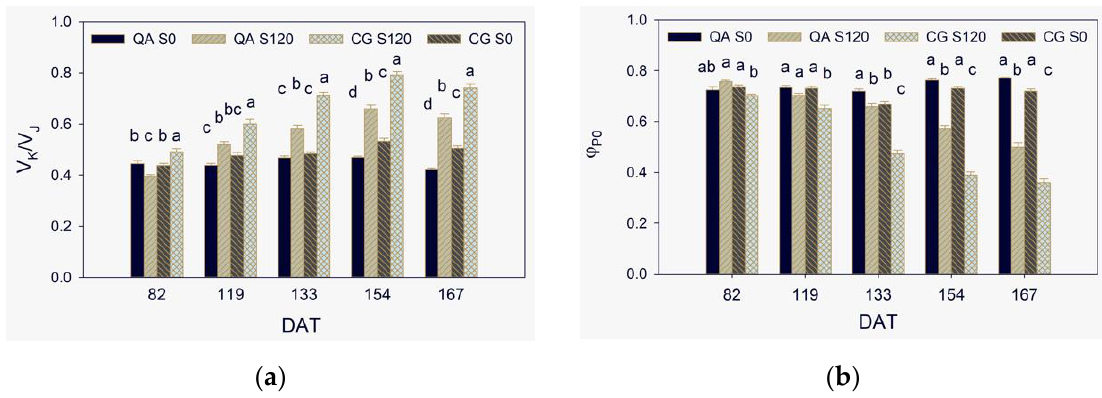
Figure 2. The ratio of V K to V J ( a ) and the maximum quantum yield of primary PSII photochemistry, ϕ Po ( b ) from DAT 82 to DAT 167. Values are the means of 24 replicates. The vertical line on each bar represents the standard error of the mean. Within each DAT, values among the four G × S combinations with the same letter are not significantly different at p < 0.05.